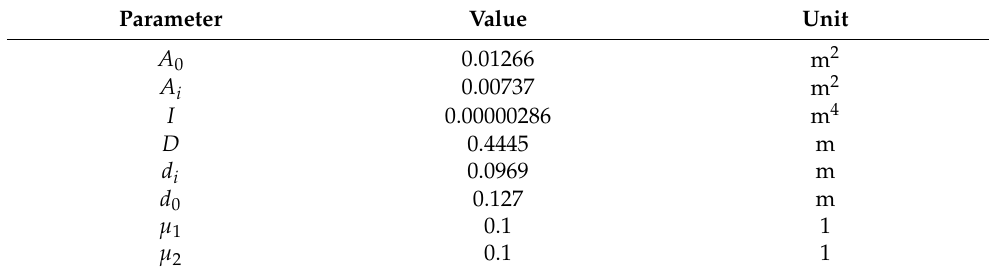
Table 1. Input parameters.